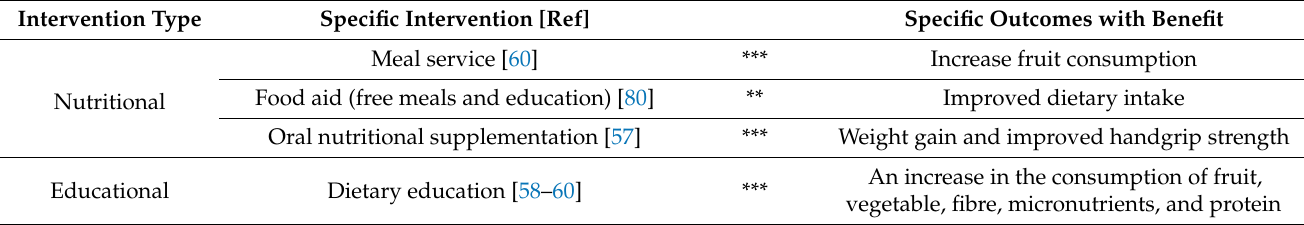
Table 4. Identified interventions for vitality